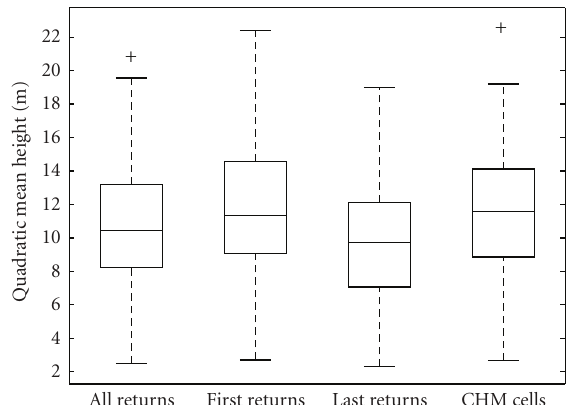
Figure 3: Boxplots of quadratic mean height derived from di ff erent LiDAR data sources.